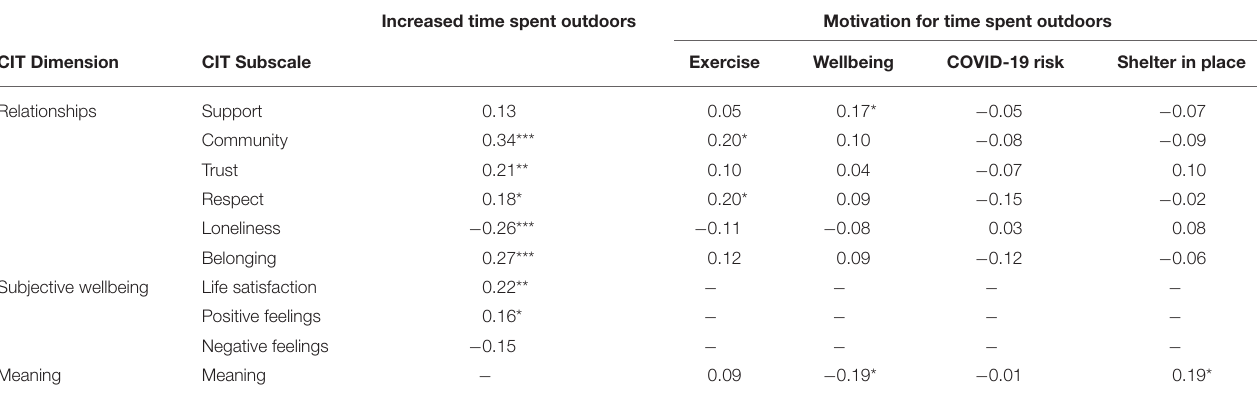
TABLE 5 | Correlations between change in time outdoors and individual differences, as warranted by randomization